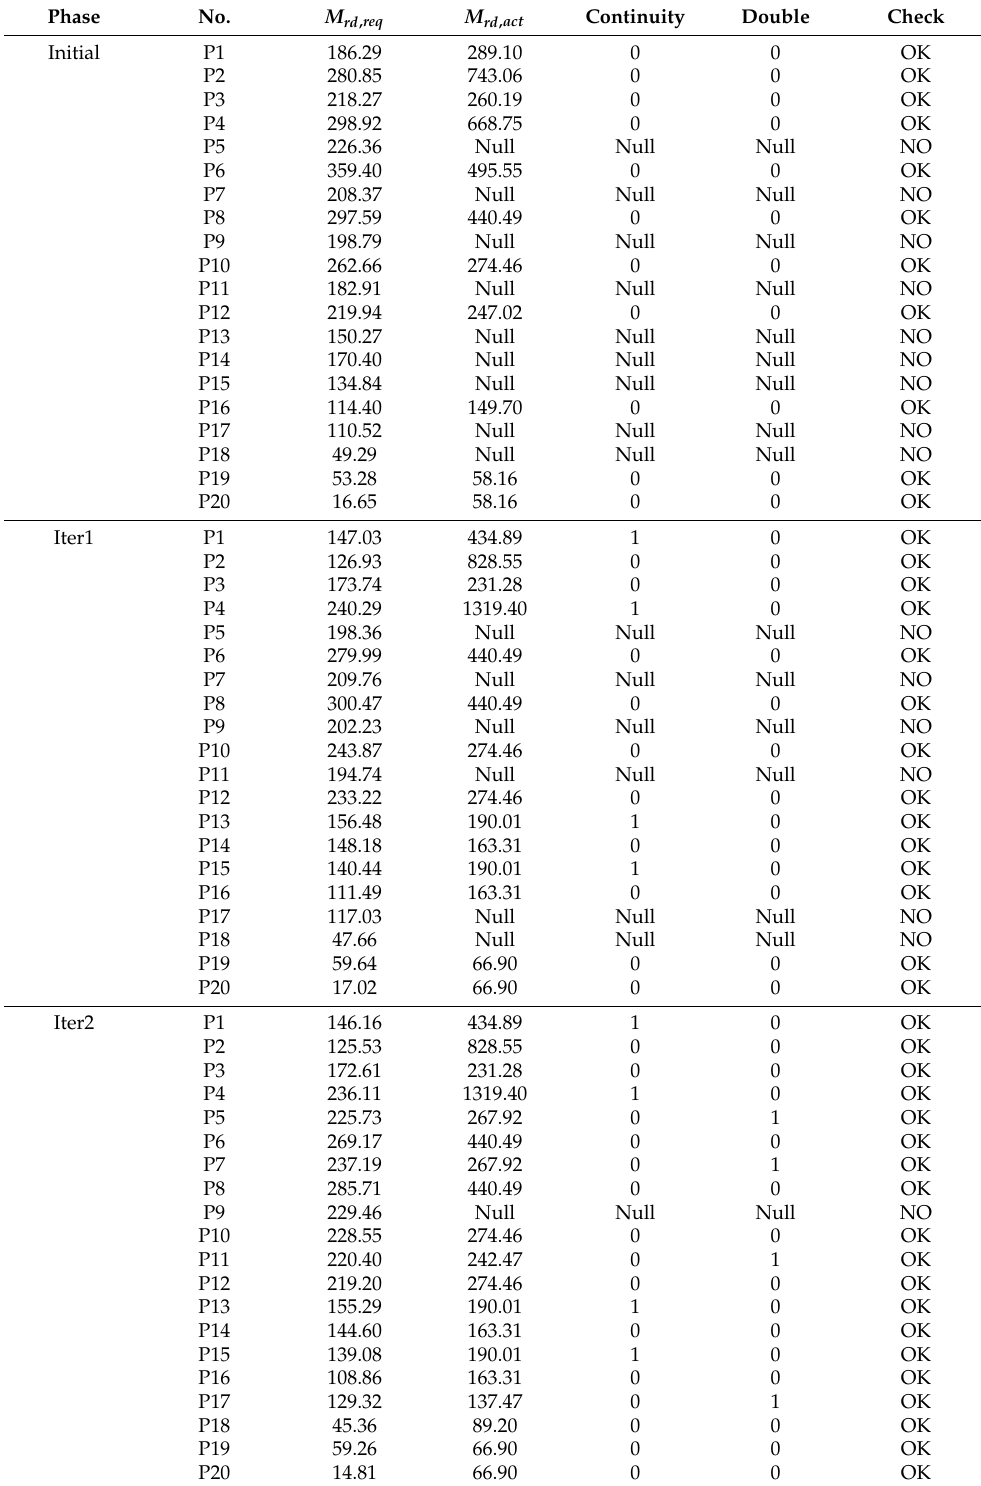
Table A5. Required web panel in each